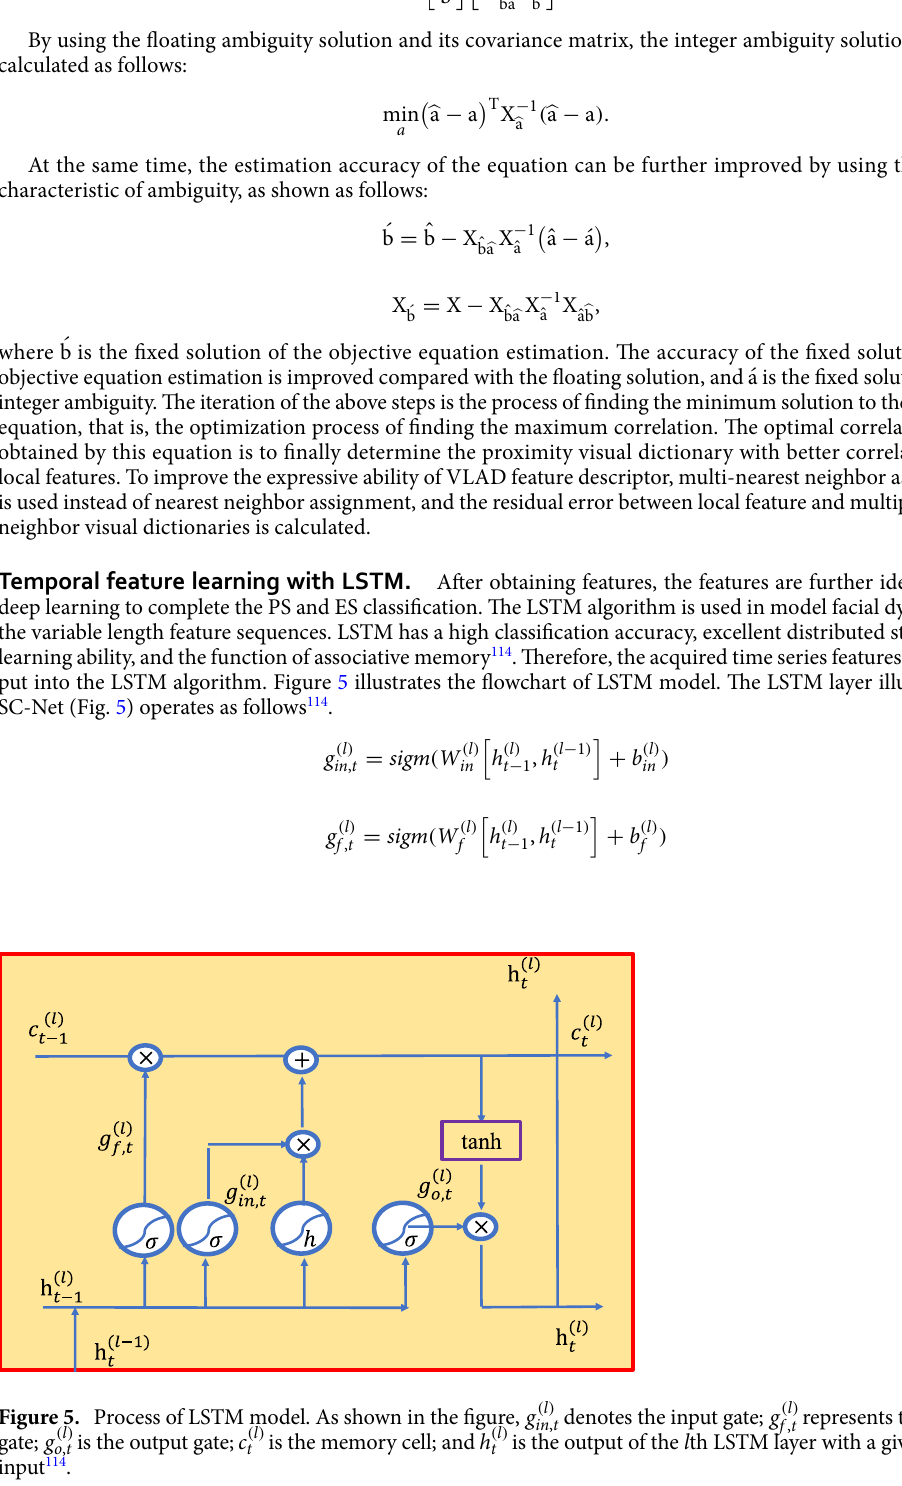
( l ) t is the memory cell; and h